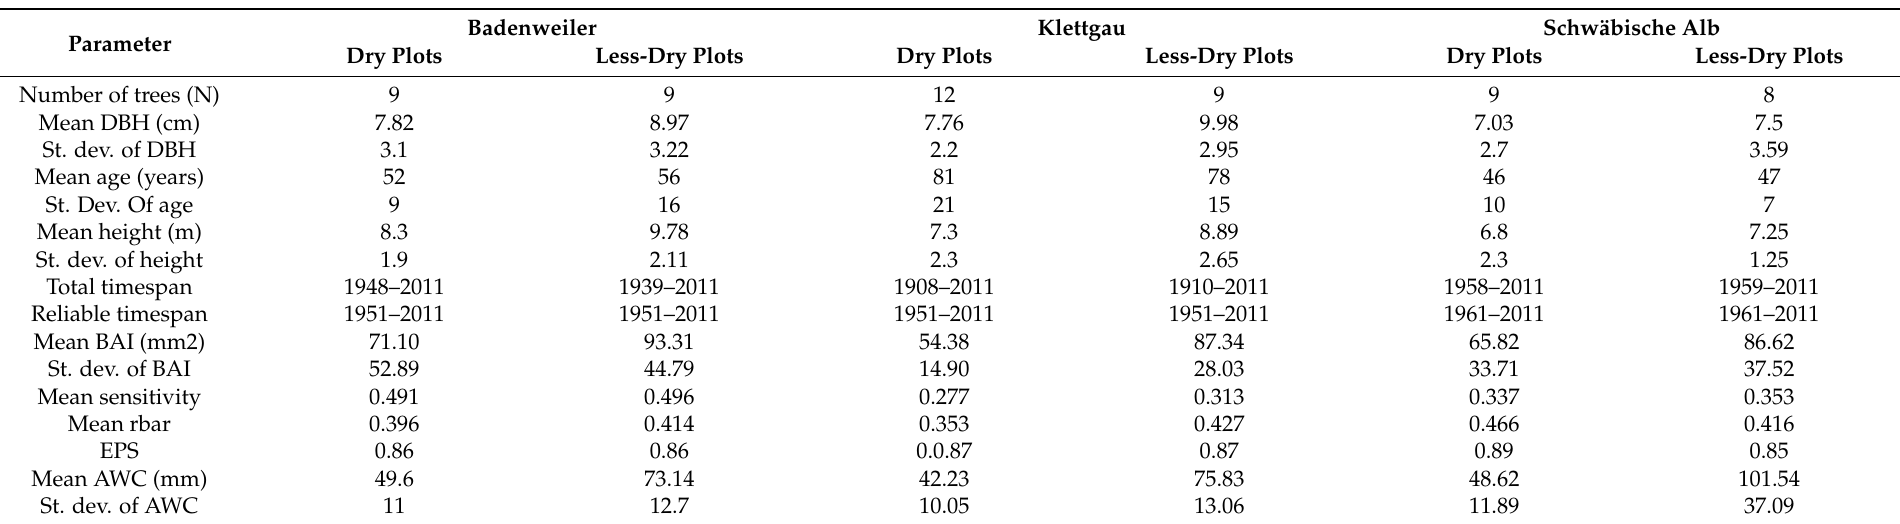
Table 2. Descriptive statistics of the sampled trees and the basal area increment chronology based on dry and less-dry plots. DBH: diameter at the height of 1.3 m, St. dev.: standard deviation,